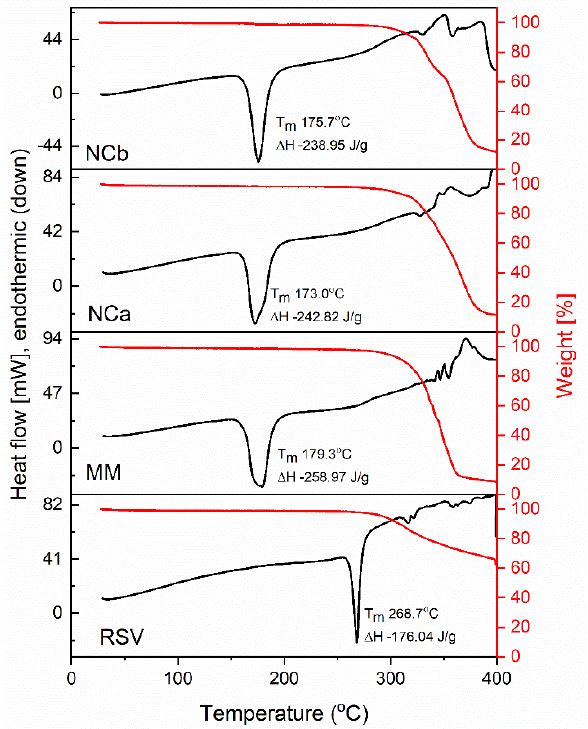
Figure 2. Thermogram of DSC (black line) and TGA (red line) of resveratrol (RSV), mannitol meso- porous (MM), and nanocrystal (NC, NCa, and NCb for Runs 12 and 15, respectively).